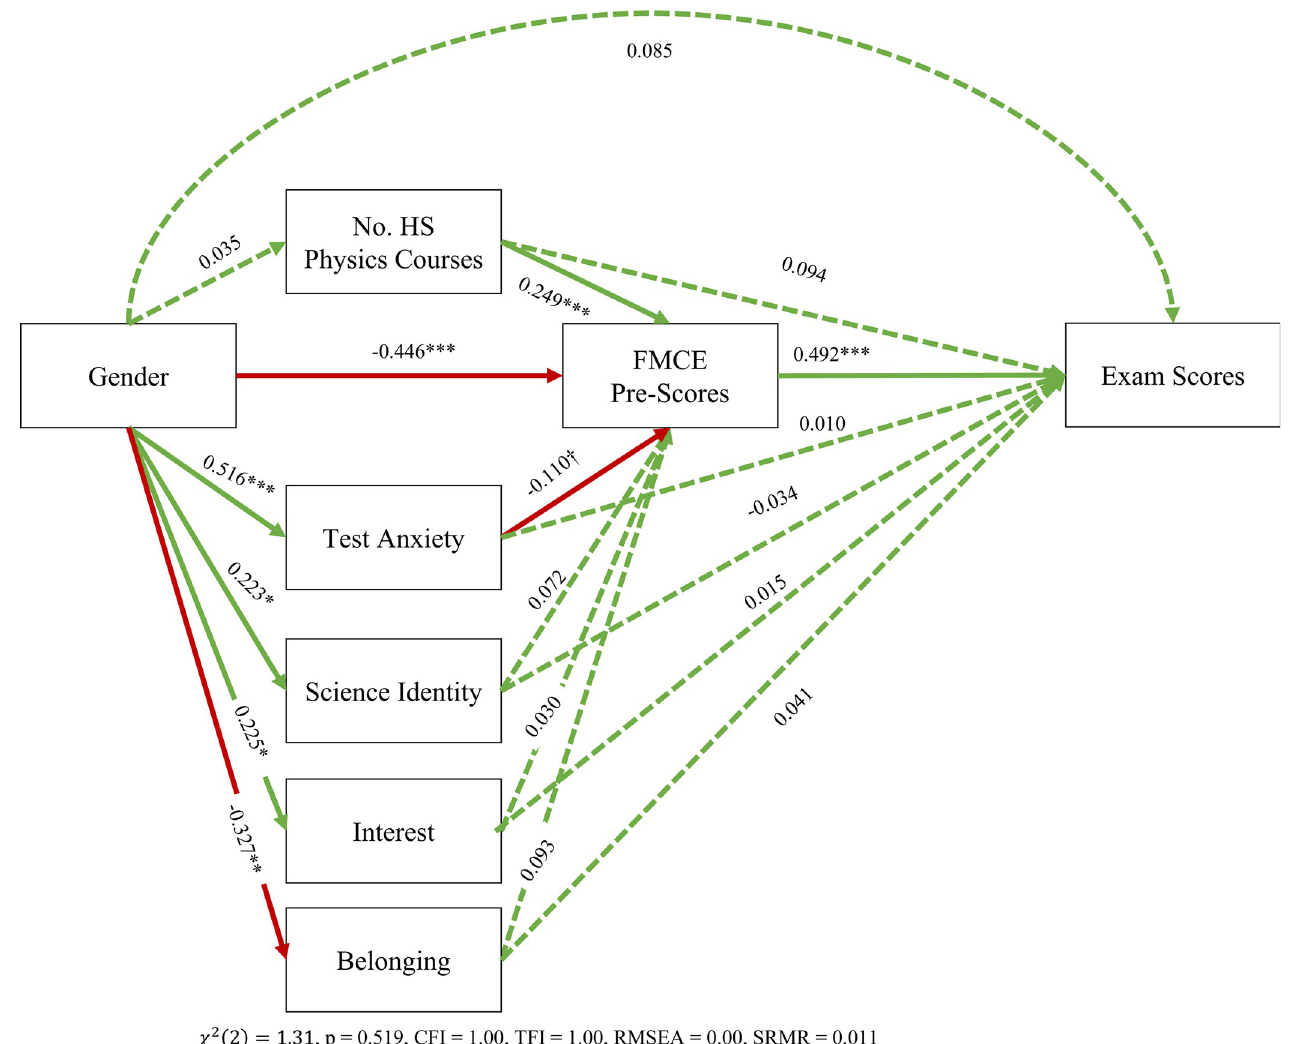
Fig 4. Extension of the model in Fig 1. We look at the effects of gender on final exam scores, as mediated by high school preparation, social-psychological factors, and performance on the FMCE. ��� p < 0.001, �� p < 0.01, � p < 0.05, † p < 0.10. Acceptable ranges: CFI > 0.95, TLI > 0.90, RMSEA < 0.08, SRMR < 0.05 and p > 0.05 for whole model. Dashed links are not significant at the p = 0.10 level. Red links indicate negative effects, while green links indicate positive